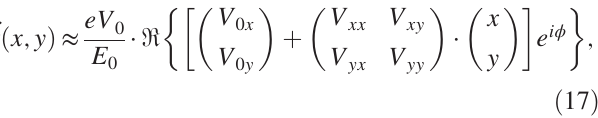
FIG. 7. Real (upper plots) and imaginary part (lower plots) of the normalized complex kick factor for the upstream (left) and downstream coupler region (right) as a function of the transverse coordinates x and y . All vectors are scaled by the same amount in order to assure a quantitative comparison. The three colors in the right plots correspond to the cases of pure forward traveling wave (yellow) in the cavity, e.g., no backward wave and Γ ¼ − 1 , standing-wave operation (red, Γ ¼ 0 ), and pure backward trav- eling wave (blue, Γ ¼ 1 ). Note that the kick induced by HOM couplers does not change for different Γ . The net effect of the FPC is primarily